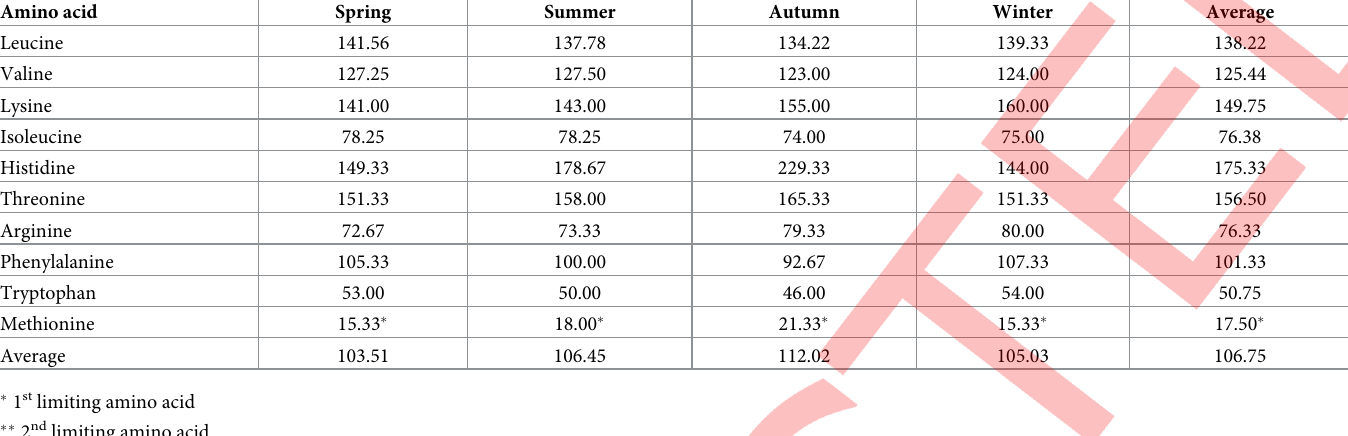
Table 6. Chemical score of bee pollen compared to the minimum requirements of honeybees ( Apis mellifera L.). Amino acid Spring